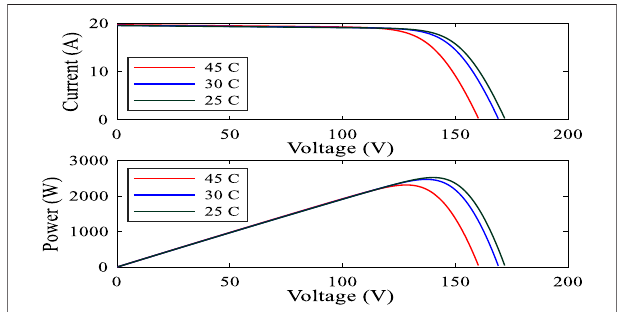
FIGURE3| I-V and P-V characteristicsof4seriesmodulesand2parallel strings at 25 ℃ , 30 ℃ , 45 ℃ temperature rating.